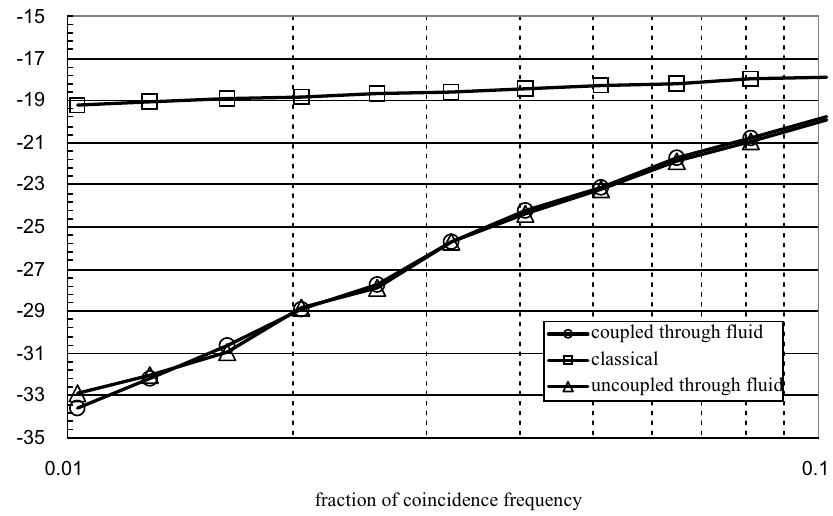
Fig. 6. Radiation efficiency of center-supported strip